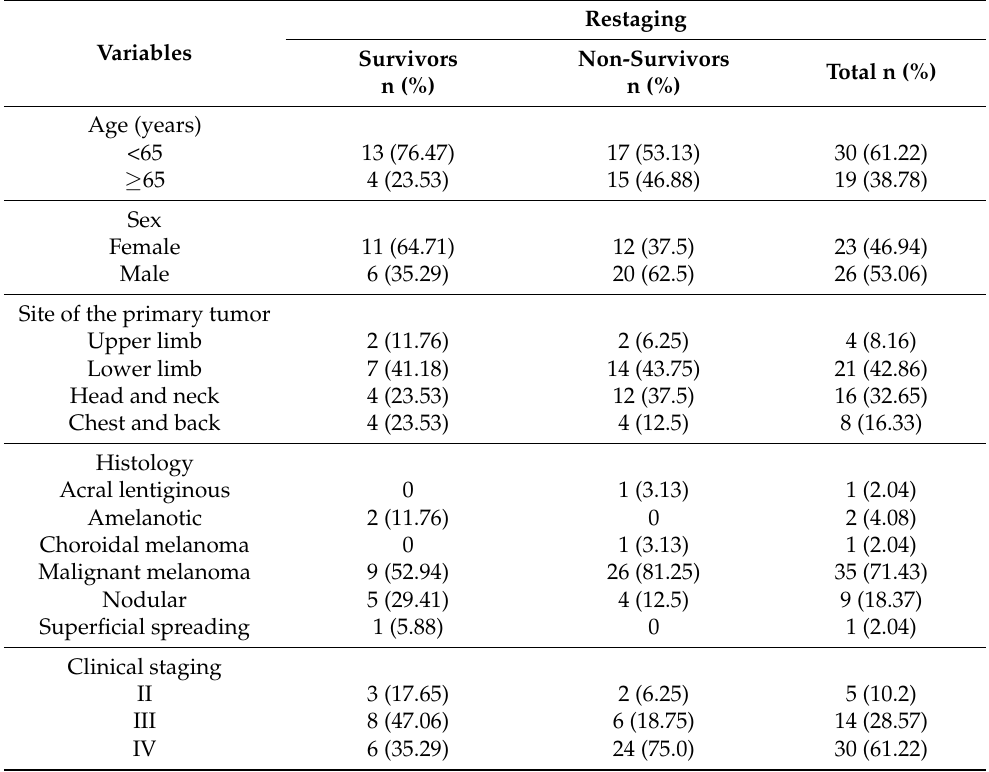
Table 1. Patient demographic and clinicopathologic